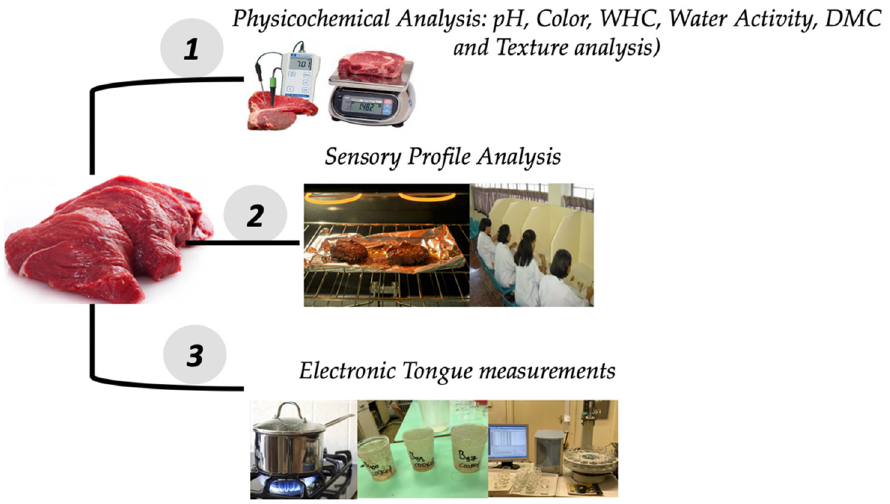
Figure 1. Graphical representation of the experimental design for the correlative analysis of different cattle species.